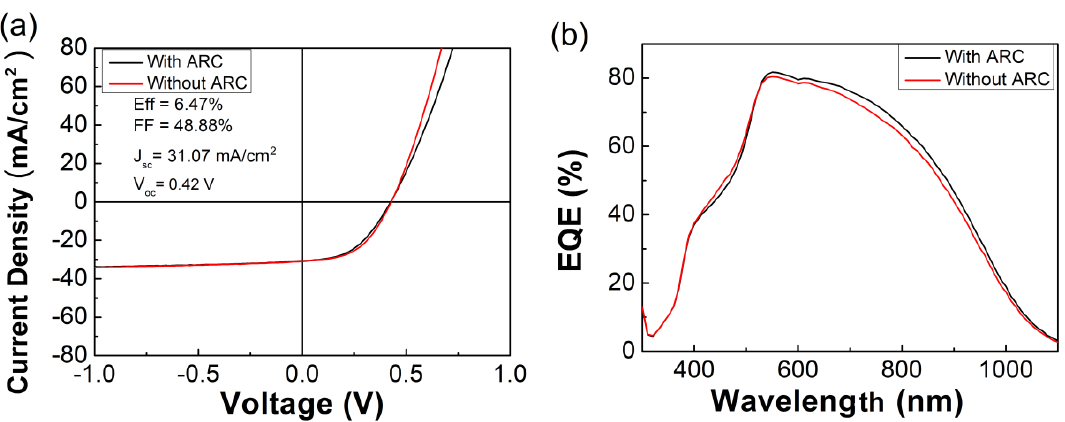
Figure 6. ( a ) Illuminated J-V curves and ( b ) EQE spectra for CZTSe films grown at 480 °C with and without anti-reflection coating (ARC).